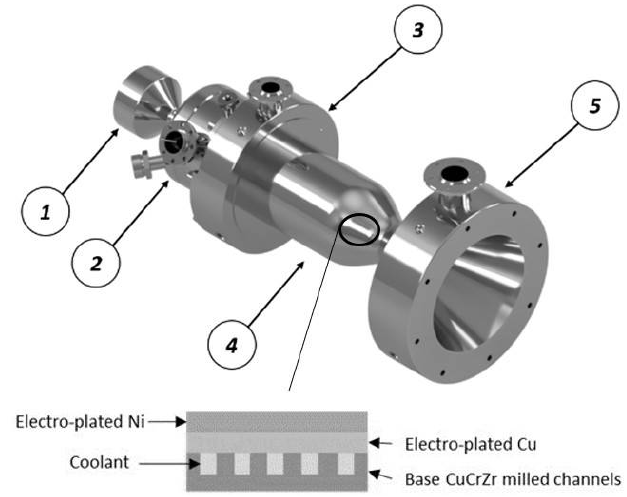
Figure 3. DEMO assembly including the main components and schematics of electroplating process applied to LRE cooling-jacket manufacturing. 1. Igniter; 2. injector head with oxidizer dome; 3. outlet fuel manifold; 4. combustion chamber, including the cooling jacket; 5. inlet fuel manifold. Table 1. Summary regarding the main performance parameters of HYPROB DEMO. O/F